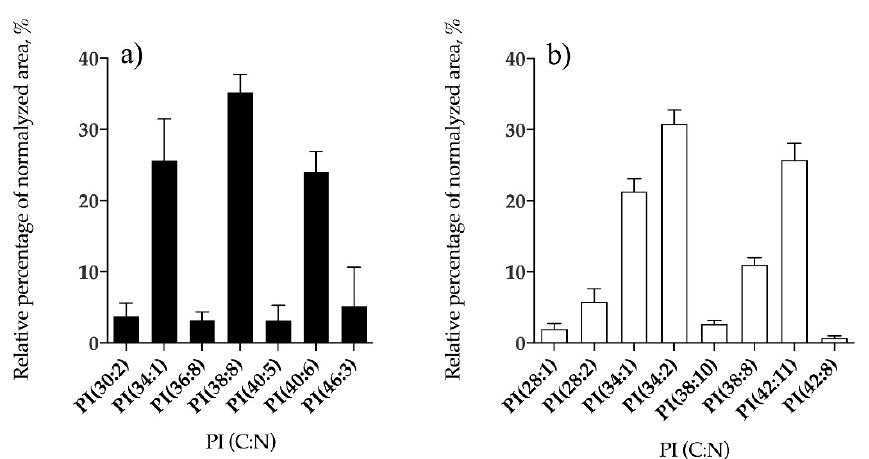
Figure 6. Relative abundance (RA) of lipid species of the phosphatidylinositol (PI) class identified in B. bifurcata ( a ) and S. muticum ( b ). The results are expressed as relative percentage after dividing the normalized peak area of each lipid species to the sum of normalized peak areas for all the lipid species within the class obtained after LC–MS analysis. Numbers in parentheses (C:N) indicate the number of carbon atoms (C) and double bounds (N) in the fatty acid side chains. The species with higher RA were PG (38:8) for B. bifurcata and PI (34:2) for S. muticum .